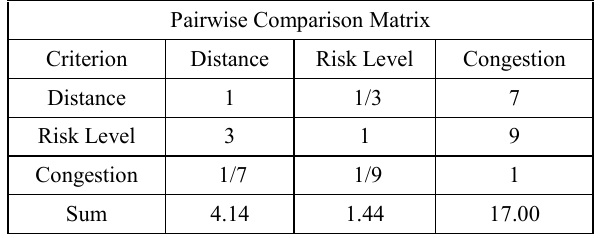
Table 1. Pairwise comparison matrix